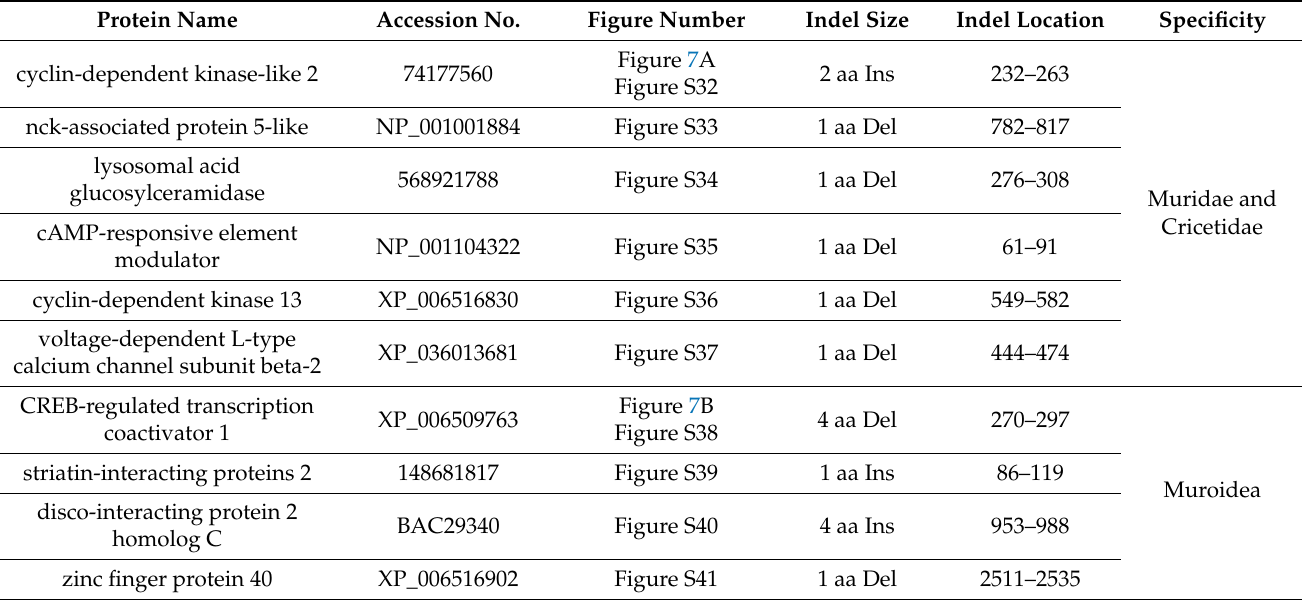
Table 3. Characteristics of the CSIs that are Specific for the Myomorpha